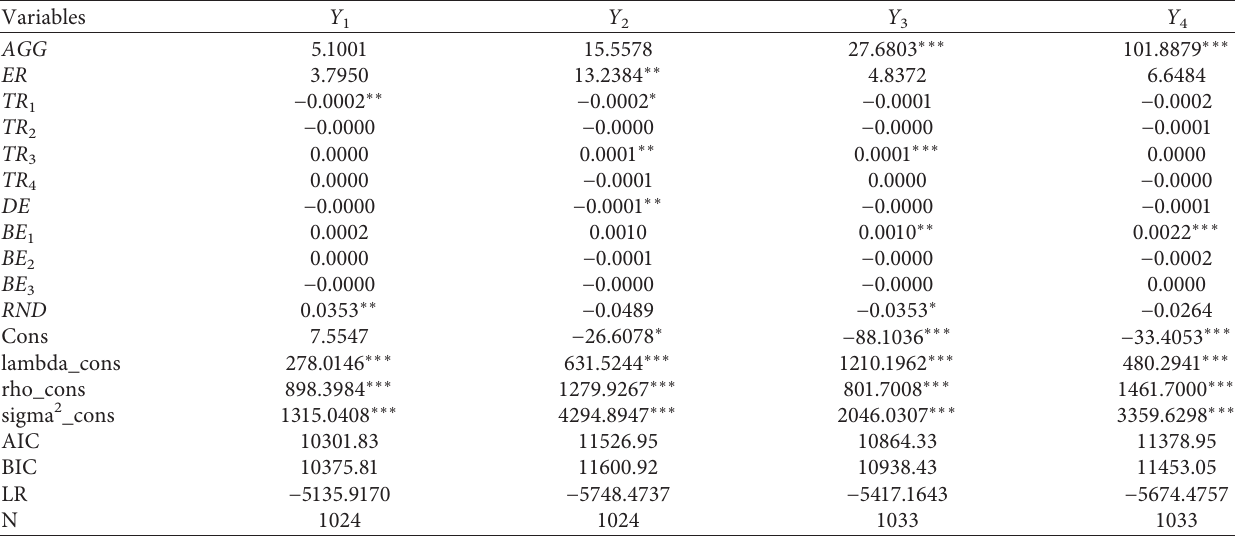
Table 4: SAR model results for the Yangtze River Economic